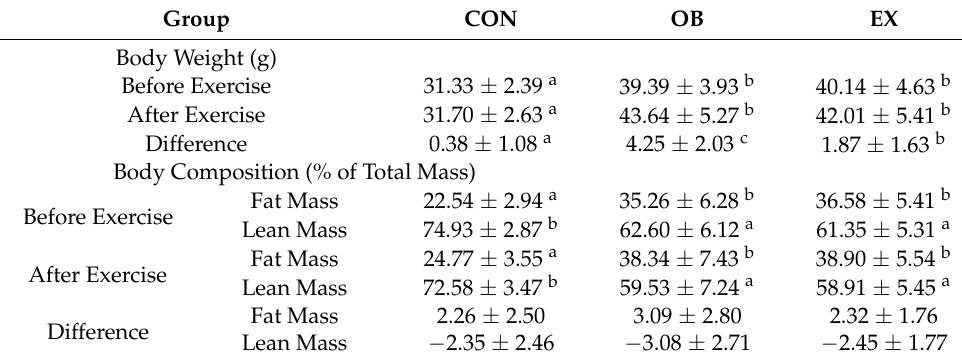
Table 1. Body composition and body weight of sarcopenic obesity-induced animals. Group